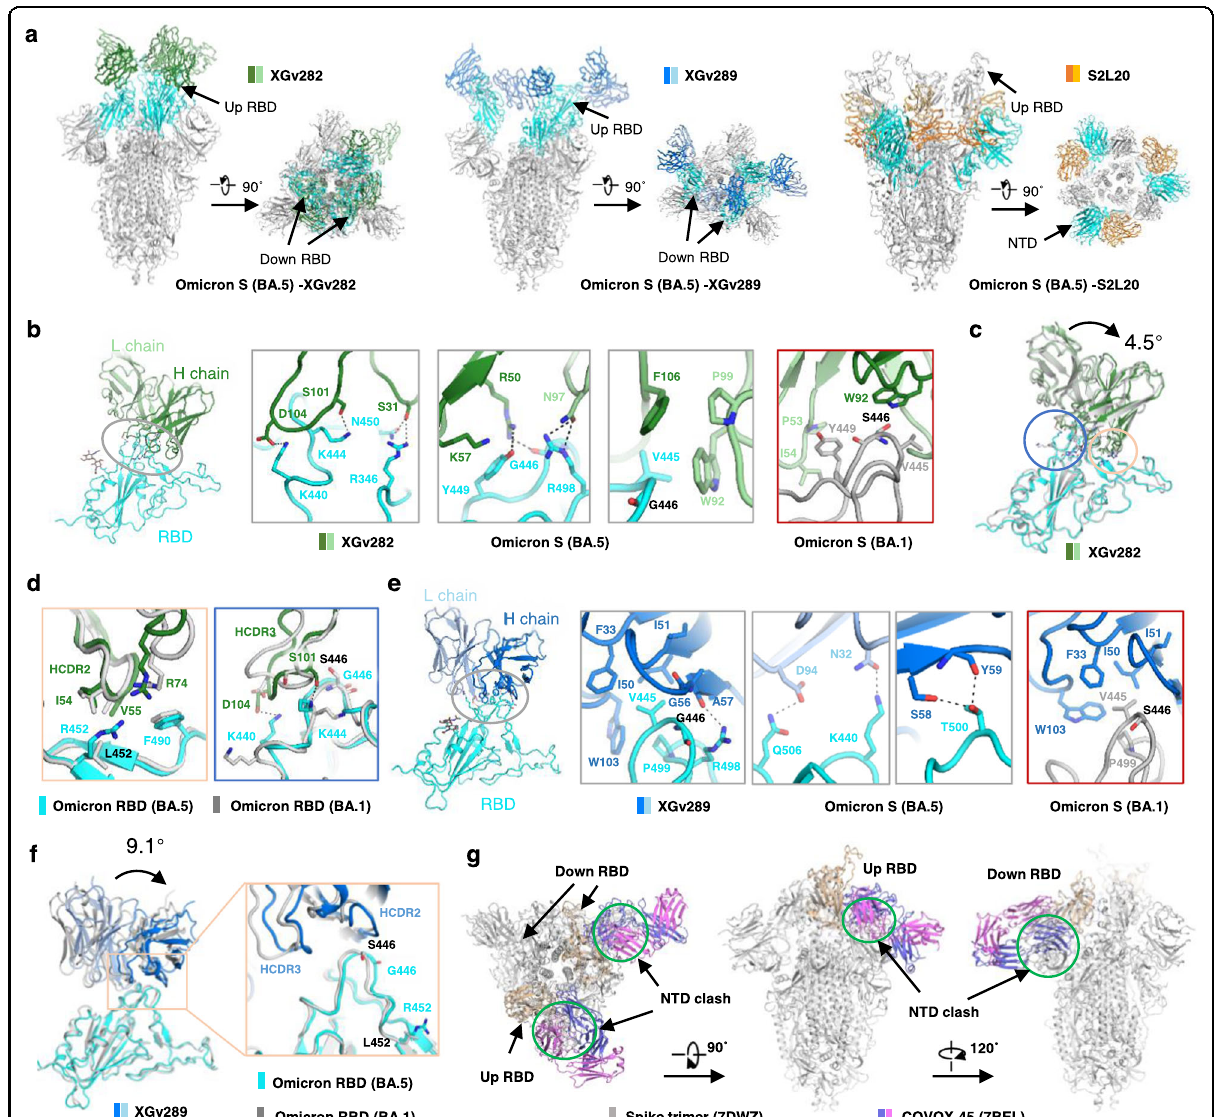
Fig. 4 Structure analysis of Omicron BA.5 S protein in complex with antibodies. a The domain-colored cryo-EM structures of Omicron BA.5 S protein in complex with XGv282, XGv289 and S2L20 are shown in two perpendicular views. The domains (RBD or NTD) bound with antibodies are colored cyan, with the other part of the S protein shown in gray. The heavy and light chains are colored green and palegreen for XGv282, marine and blue for XGv289, and orange and yellow for S2L20, respectively. b The binding interface between Omicron BA.5 RBD and XGv282. Extensive hydrophobic and hydrophilic interactions on the interface are shown in three gray boxes. The red-framed right panel is the binding interface between Omicron BA.1 RBD and XGv282 (PDB ID: 7WLC). Black dashed lines indicate polar interactions. c , d Structural comparison of the Omicron BA.5 RBD – XGv282 complex and the Omicron BA.1 RBD – XGv282 complex (PDB ID: 7WLC). The RBD is superimposed, with the circled regions shown in detail in d . The heavy and light chains of XGv282 are colored green and pale green, respectively. RBD is colored cyan and gray for Omicron BA.5 and BA.1, respectively. e is the same as ( b ), but for XGv289. The red-framed right panel is the binding interface between Omicron BA.1 RBD and XGv289 (PDB ID: 7WE9). f Structural comparison of the Omicron BA.5 RBD – XGv289 complex and the Omicron BA.1 RBD – XGv289 complex (PDB